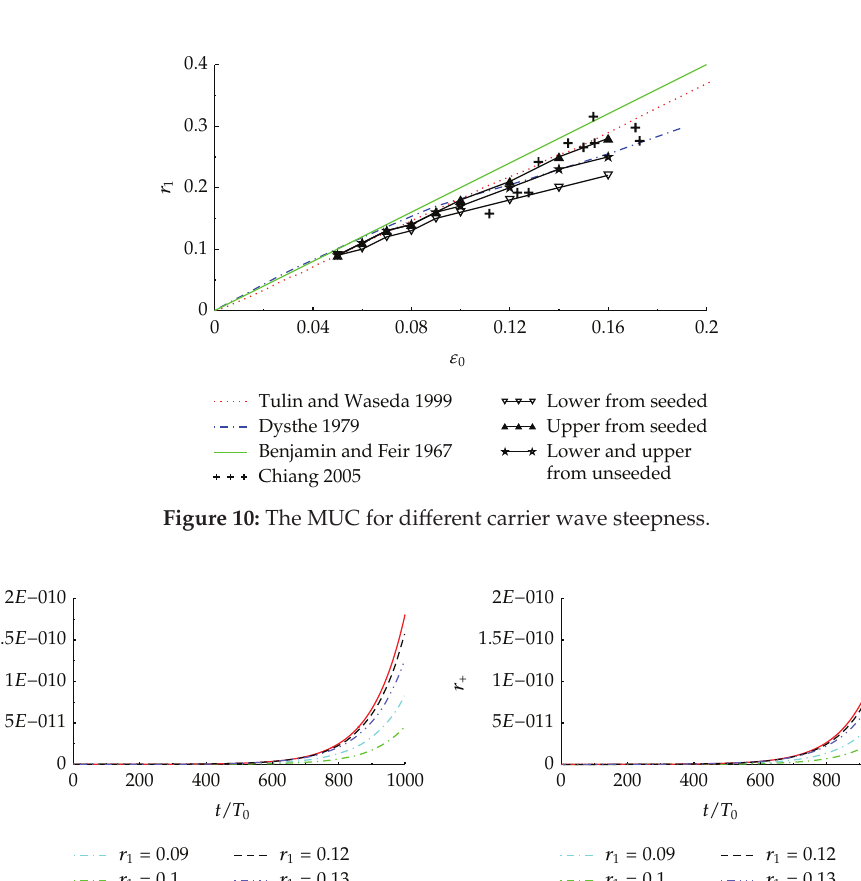
Figure 9: The amplitude evolution processes of lower sidebands (cid:2) a (cid:3) and upper sidebands (cid:2) b (cid:3) for case ε (cid:7) 0 . 06. 0